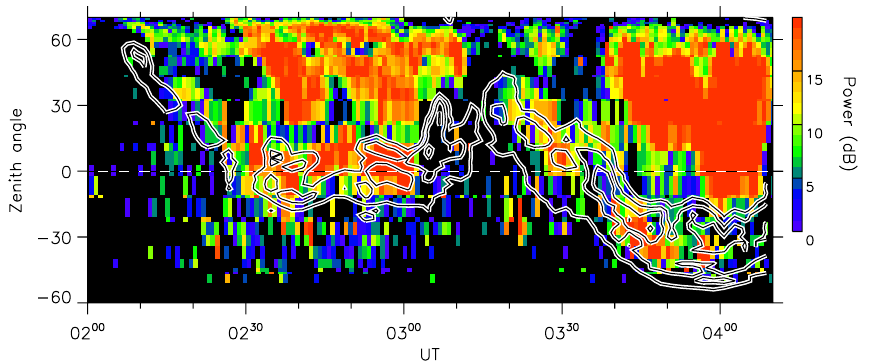
Fig. 5. A comparison of the backscatter power keogram, assuming an optical emission altitude of 110km, and the visual luminosity keogram (contours).